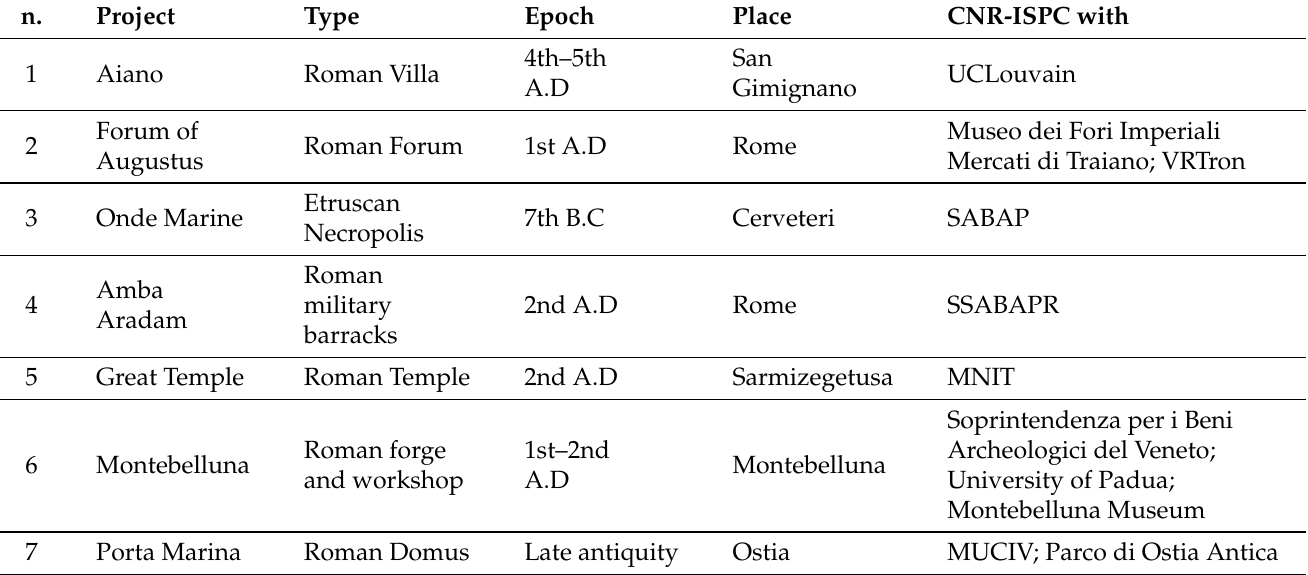
Table 1. Summary of the main characteristics of the case